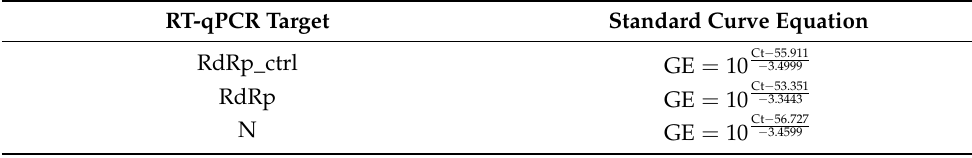
Table 3. RT-qPCR standard curve equations to convert Ct value to genomic equivalents